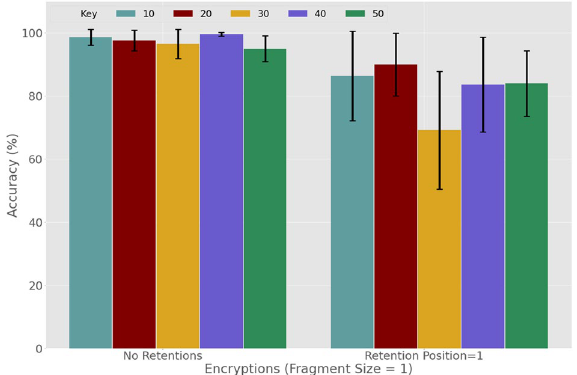
Figure 9. DNN-based detection of trigger samples amongst genuine E. coli plasmids: the impact of nucleotide retention, no knowledge of the encryption